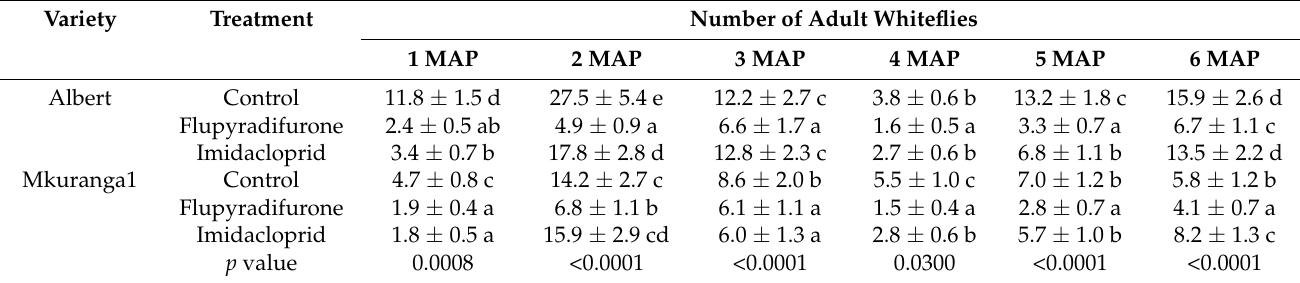
Table 5. Abundance of adult whitefly in the cutting dip experiment, 2020 (Means ± SE) Z .